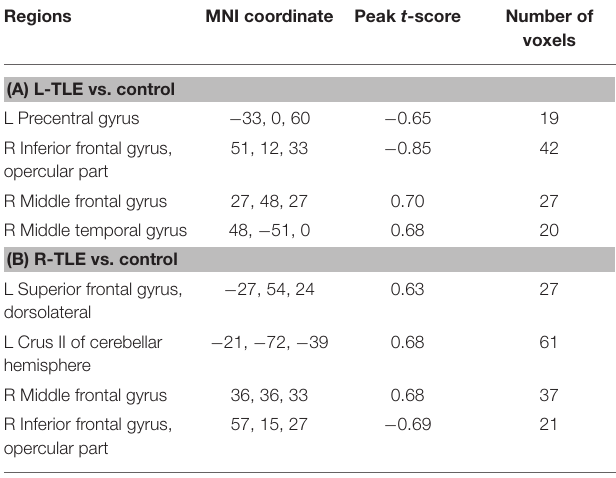
TABLE 7 | The associated cortical area, whose GMD changes had the same degree of volumetric changes of the thalamic unit on each side in R-TLE. Regions MNI coordinate Peak t -score Number of voxels